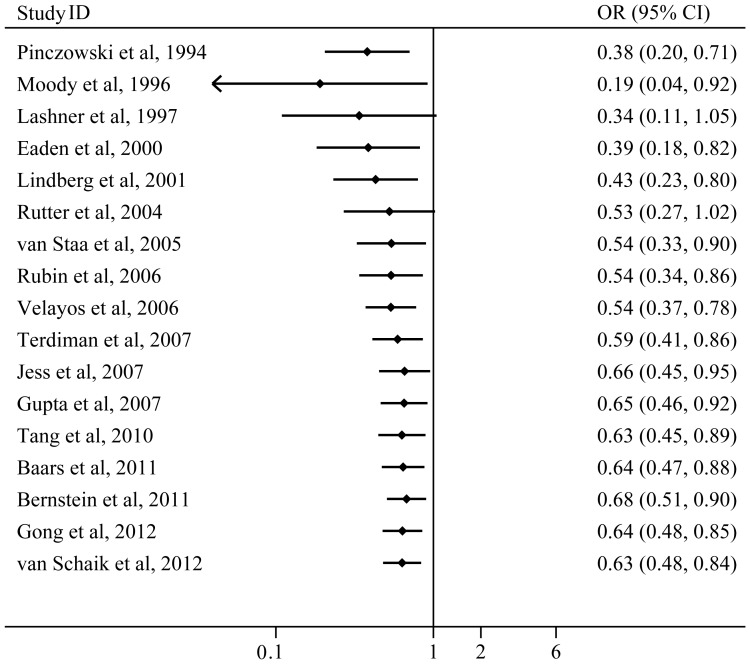
Forest plot of cumulative meta-analysis over time.